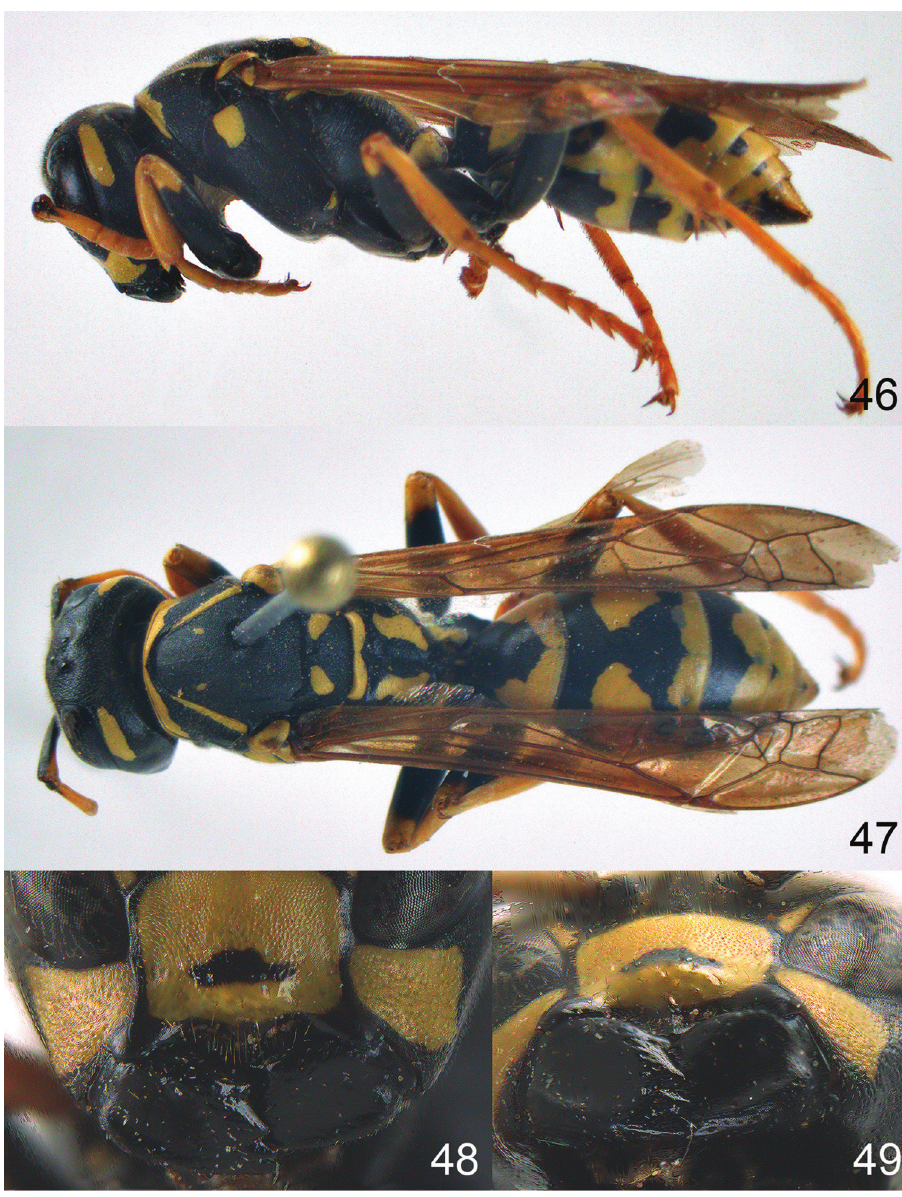
view 48 lower part of head in frontal view 49 head in ventral view. lose and epicnemium only superficially micro-sculptured; propodeum coarsely trans- versely striate. fore wing including pterostigma and veins reddish brown. Variations . Body length of paratypes similar to holotype. Left mandible of one paratype with small yellow spot, and clypeus all yellow in one